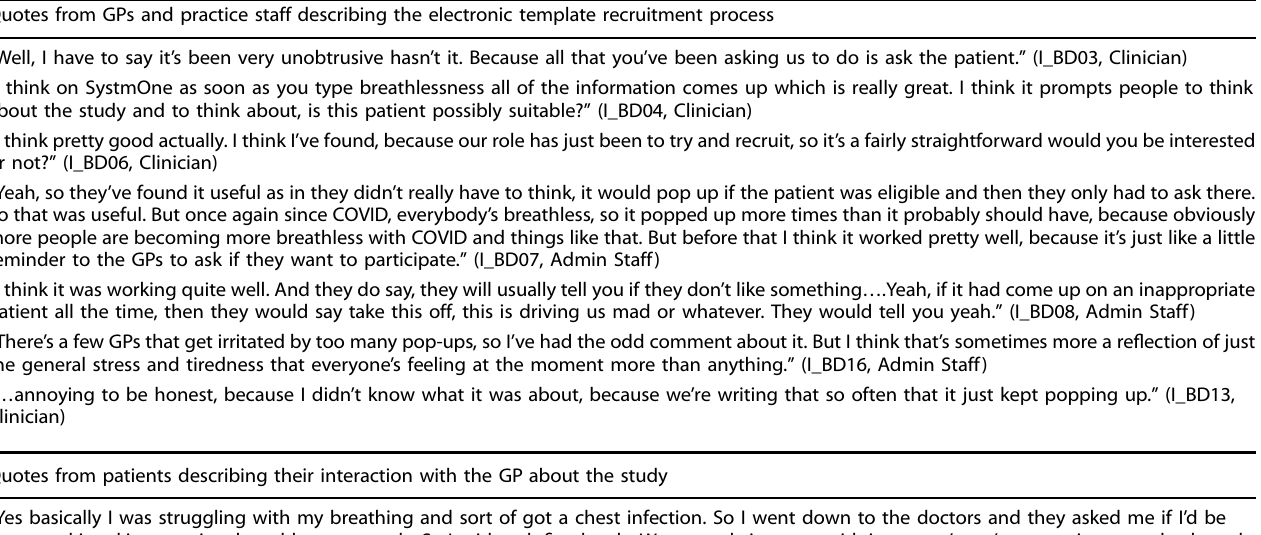
Table 1. Healthcare practitioner and patient experience of recruitment at the time of presentation supported by an electronic ‘ pop-up ’ template (Strategy